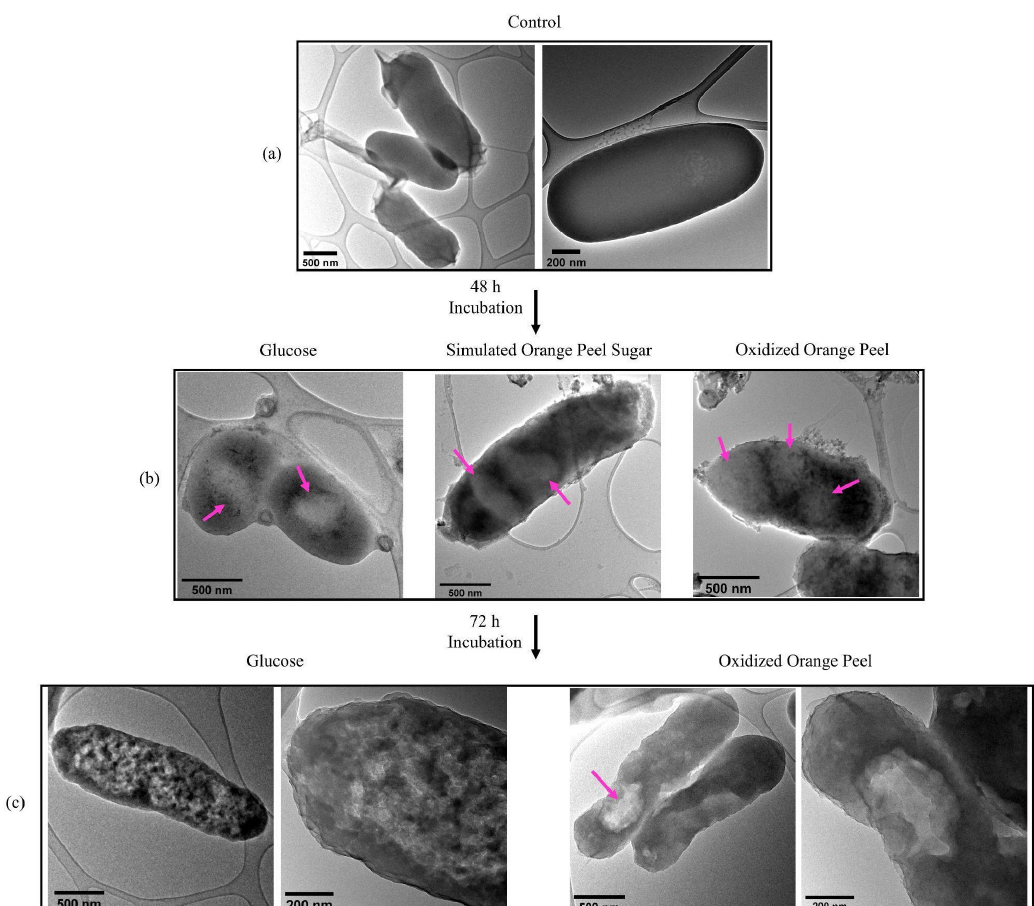
Figure 9. ( a ) Transmission electron micrographs of JM109 grown in LB without any carbon source (control) (depicted in two magnifications); ( b ) PHB granules in JM109 when fed with glucose, simulated orange peel sugars, and oxidized orange peel liquor after 48 h; ( c ) PHB clusters and granules in JM109 when fed with glucose (depicted in two magnifications) and oxidized orange peel liquor after 72 h incubation (depicted in two magnifications).